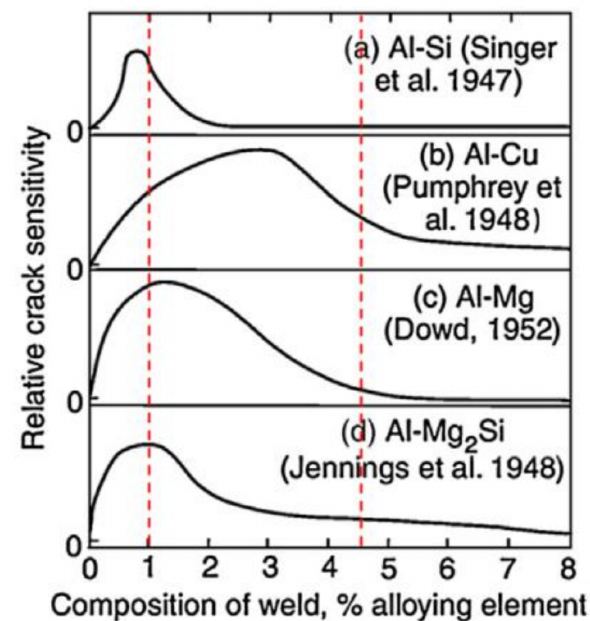
Figure 8. The effect of different elements on aluminum crack sensitivity [62]. ( a ) Si; ( b ) Cu; ( c ) Mg; ( d )